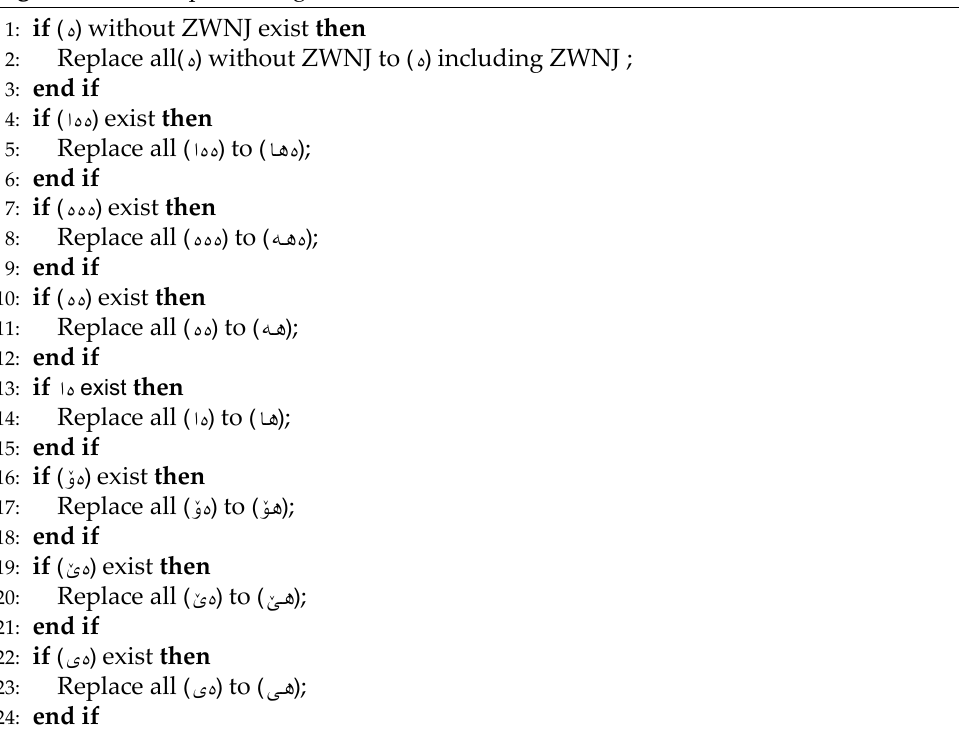
Algorithm 1 Post‑processing